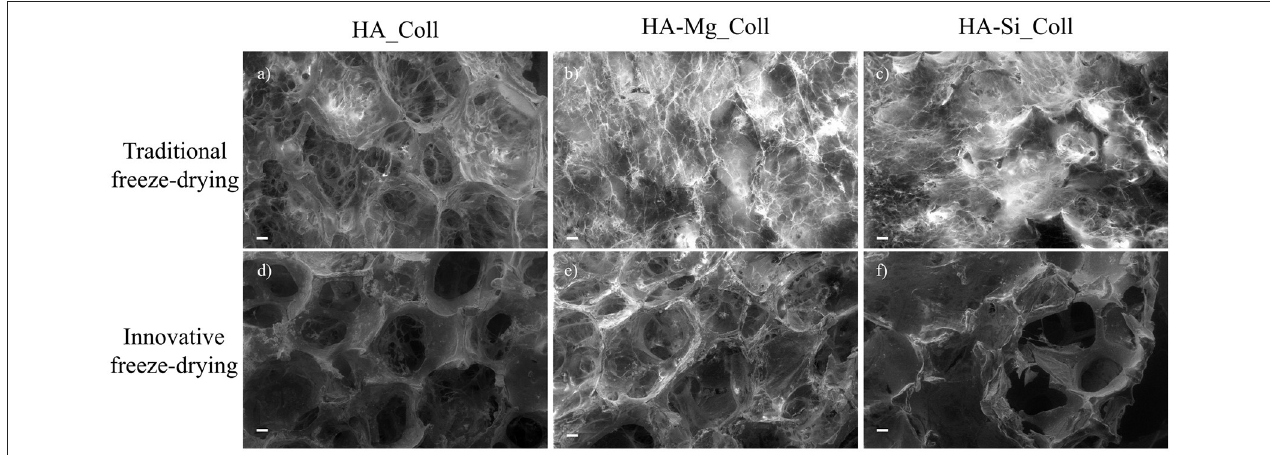
FIGURE 2 | SEM images (scale bar: 200 µ m) of the HA_Coll, HA-Mg_Coll, and HA-Si_Coll scaffolds freeze-dried with traditional (a–c) and innovative (d–f) approach.